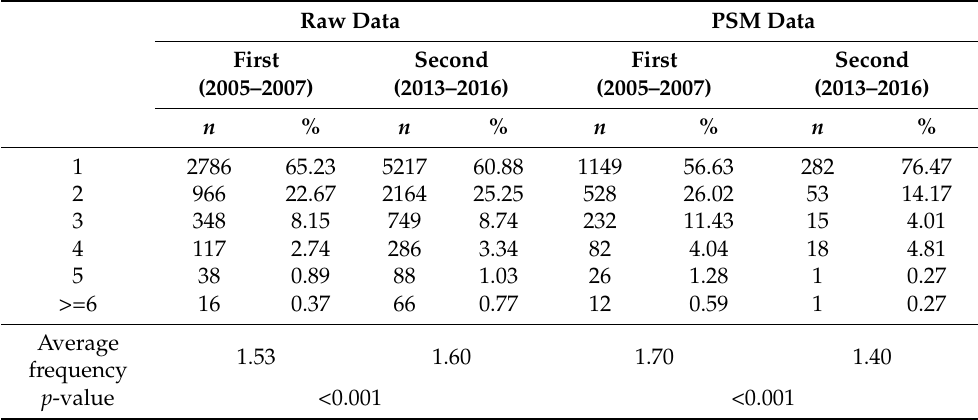
Table 3. Number of previous induced abortion among participating women in two surveys. Raw